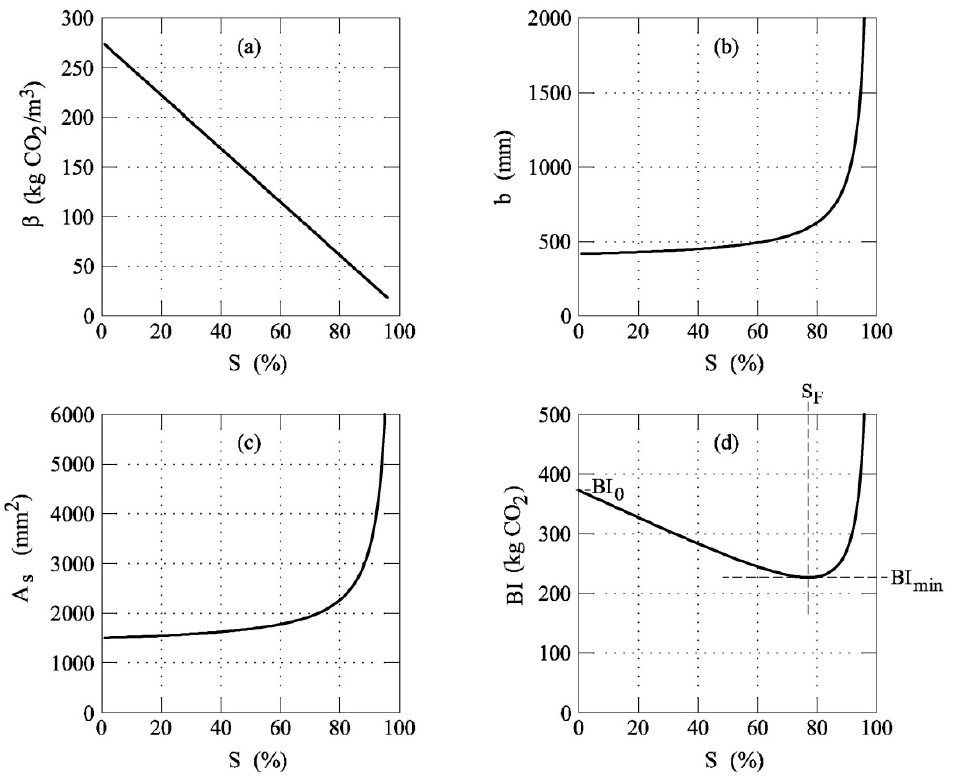
Figure 6. The result of the procedure herein proposed to design RC beams in bending with f ck = 25 MPa: ( a ) β - S function; ( b ) b - S function, ( c ) A s - S function; and ( d ) BI - S function.